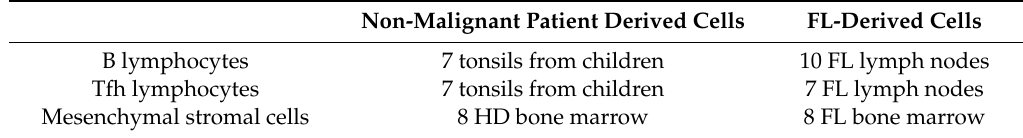
Table 1. Characteristics of cohort for transcriptomic